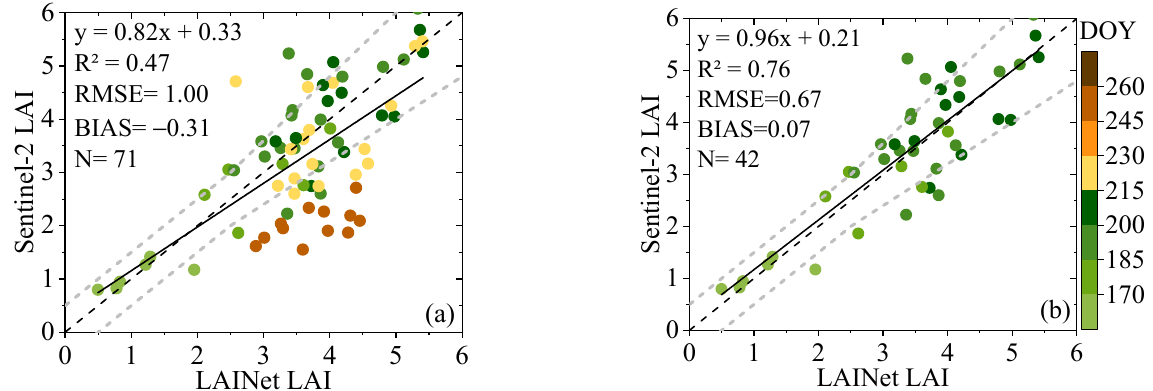
Figure 5. Comparison between the Sentinel-2 LAI and LAINet for ( a ) the entire time period (from day of year (DOY) 152 to 263) and ( b ) for the green-up period (from DOY 152 to 211). The black dashed line indicates 1:1 line, and solid line indicates linear regressions between Sentinel-2 LAI and LAINet. The gray dashed lines show the Global Climate Observing System uncertainty requirements for LAI (max (0.5, 20%)).